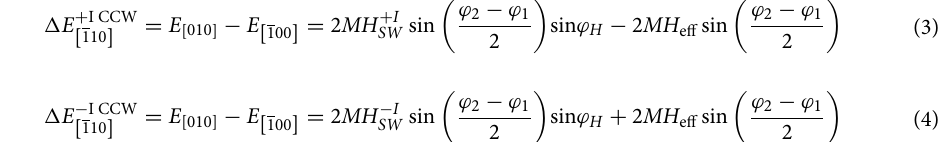
+ I CCW (cid:31) E − I CCW where (cid:31) E [ 110 ] and [ 110 ] represent the domain pinning energies that occur in the CCW rotation when the current is positive and negative, respectively 28,35 ; and angles ϕ 1 and ϕ 2 indicate magnetization directions in the 2nd and 3rd quadrants before and after the transition across the Equations (3) and (4) can be rearranged to obtain a relation between H